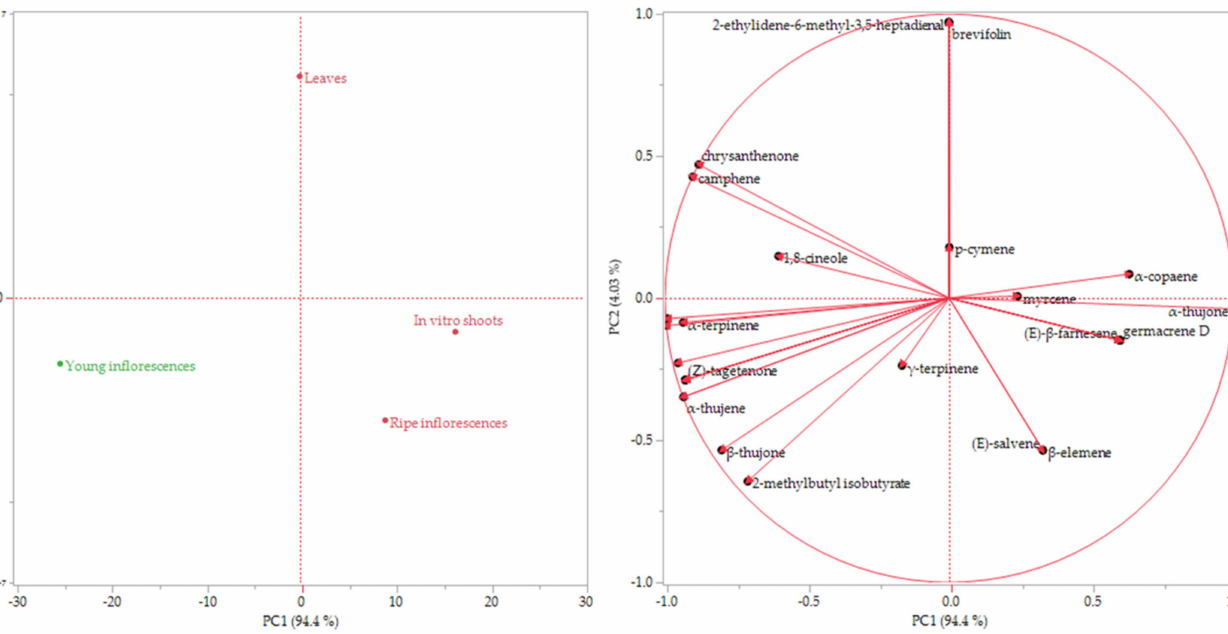
Figure 3. Score ( a ) and loading ( b ) plots of the principal component analysis (PCA) performed on the complete composition of the sample